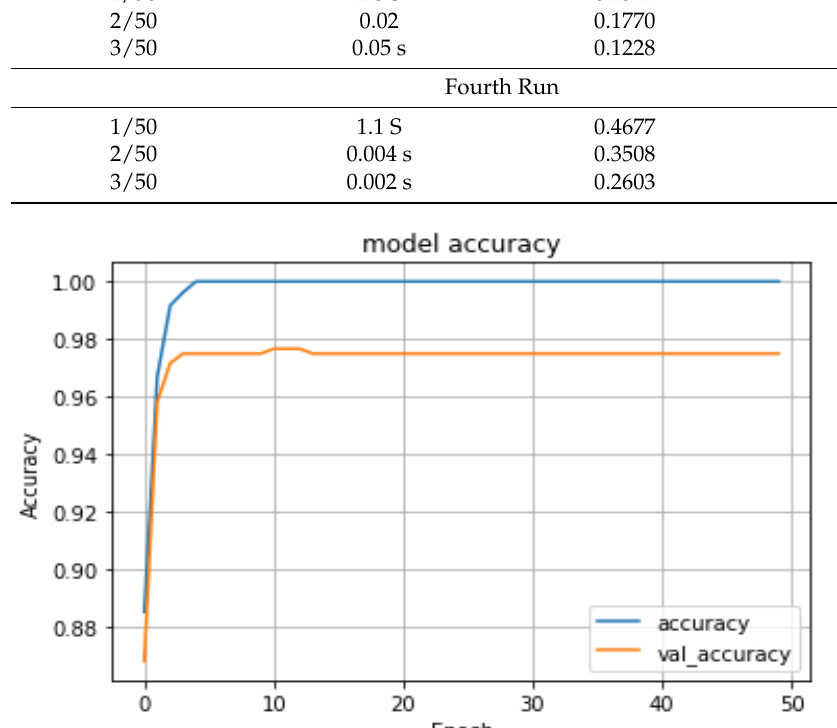
Figure 5. C3-enabled CNN LSTM model loss.